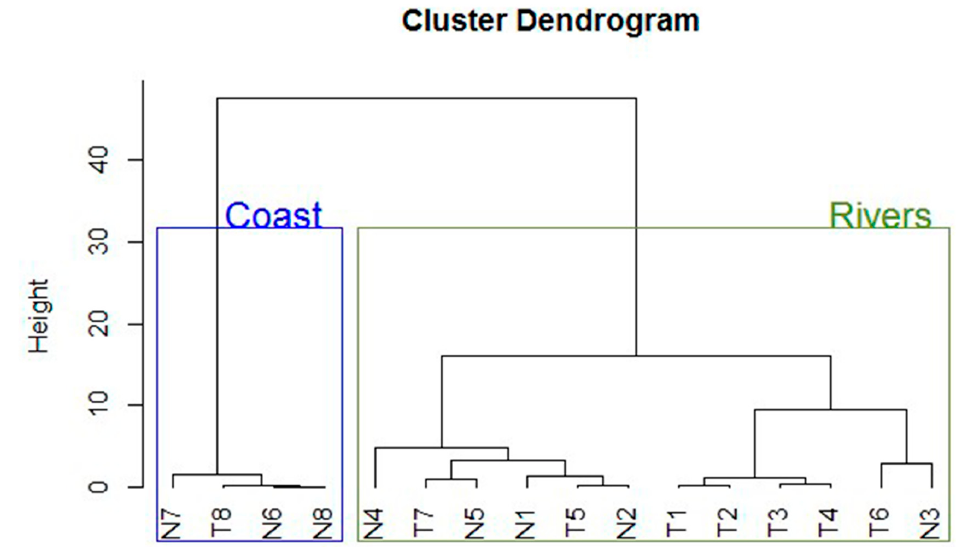
Figure 3. Cluster dendogram using the squared Euclidean distance and Ward’s method. Classification variables are ammonium, nitrate and organic nitrogen concentrations.